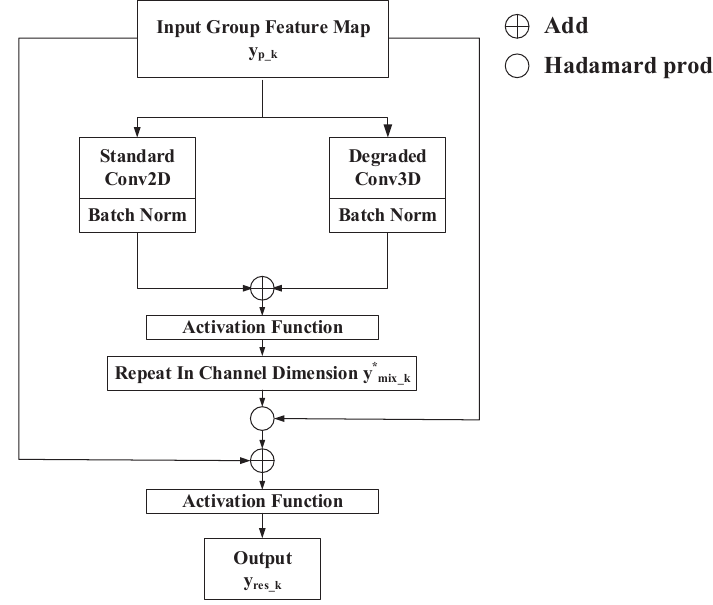
Figure 2. The Flowchart of the Parallel Design of The SPEM Spatial Neighborhood Enhancement (SANE) Block: According to the excellent per- formance of 2D convolution kernel in modeling the local dependencies between nearby pixels, the SANE block also uses 2D kernels with the size of 3 × 3 to extract the spatial neighborhood features. The calculation is the same as the 2D convolution operation in Equation (3), where y p is the k th selected group feature maps from the output of CAM, k (cid:12) means the standard convolution operation and y ∈ R w × h × 1 indicates the spatial spa k enhancement feature map. ω and b indicate weight and bias,